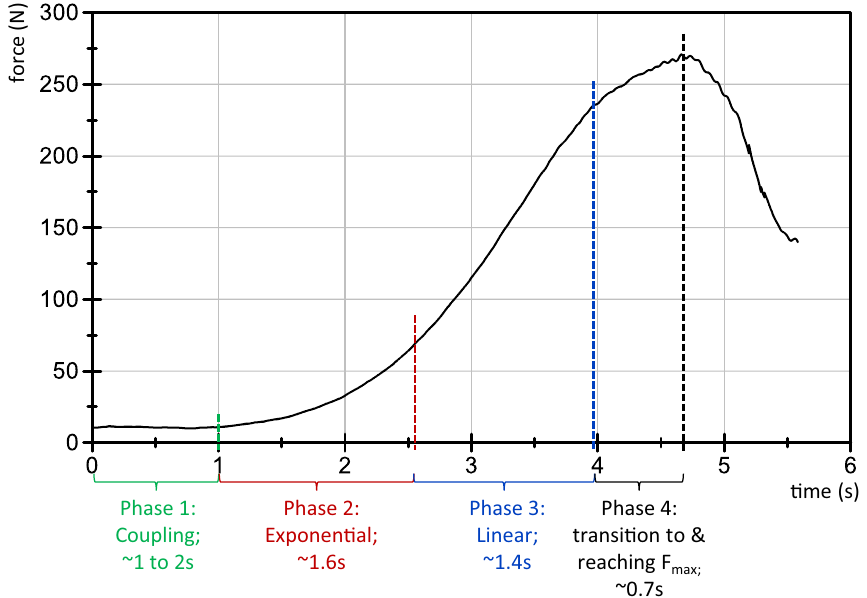
Figure 1. Schematic force profile. The force increase applied externally by the tester during the MMT consists of the four illustrated phases. (according to Bittmann et al. 39 ).